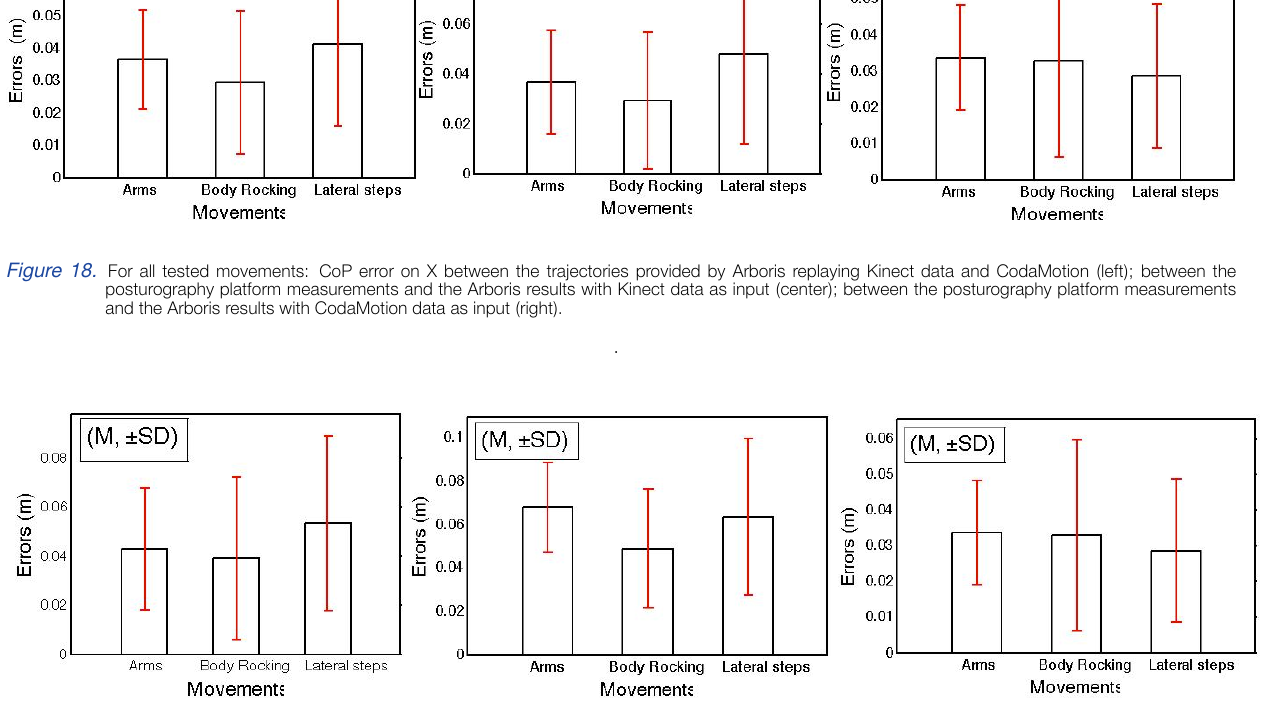
Figure 19. For all tested movements: CoP error on Y between the trajectories provided by Arboris replaying Kinect data and CodaMotion (left); between the posturography platform measurements and the Arboris results with Kinect data as input (center); between the posturography platform measurements and the Arboris results with CodaMotion data as input (right). .